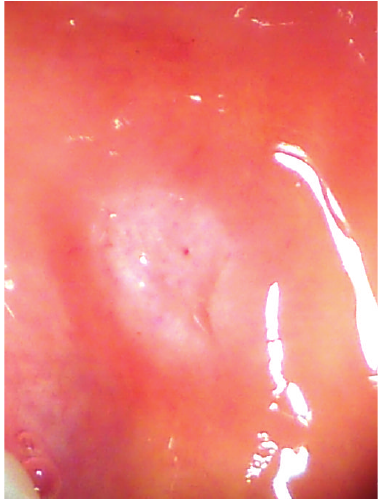
Figure 4: Intraoral photo of the granular cell tumour a ff ecting the buccal mucosa.